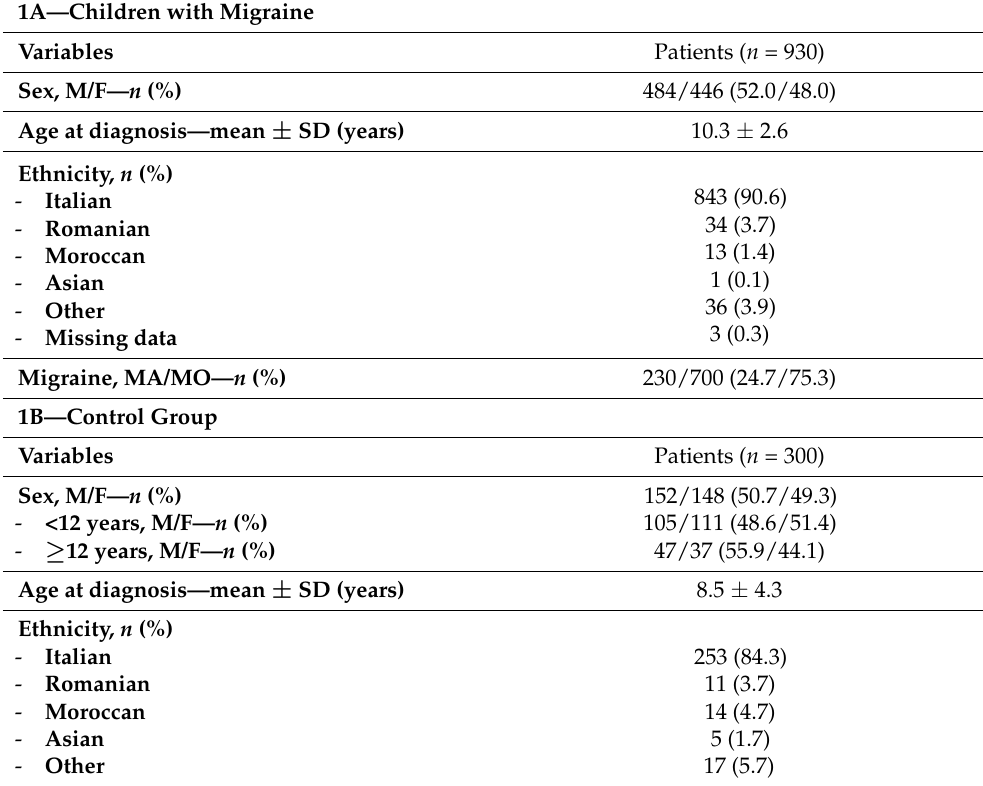
Table 1. Epidemiological features of the study population with migraine (1A) and the control group (1B).